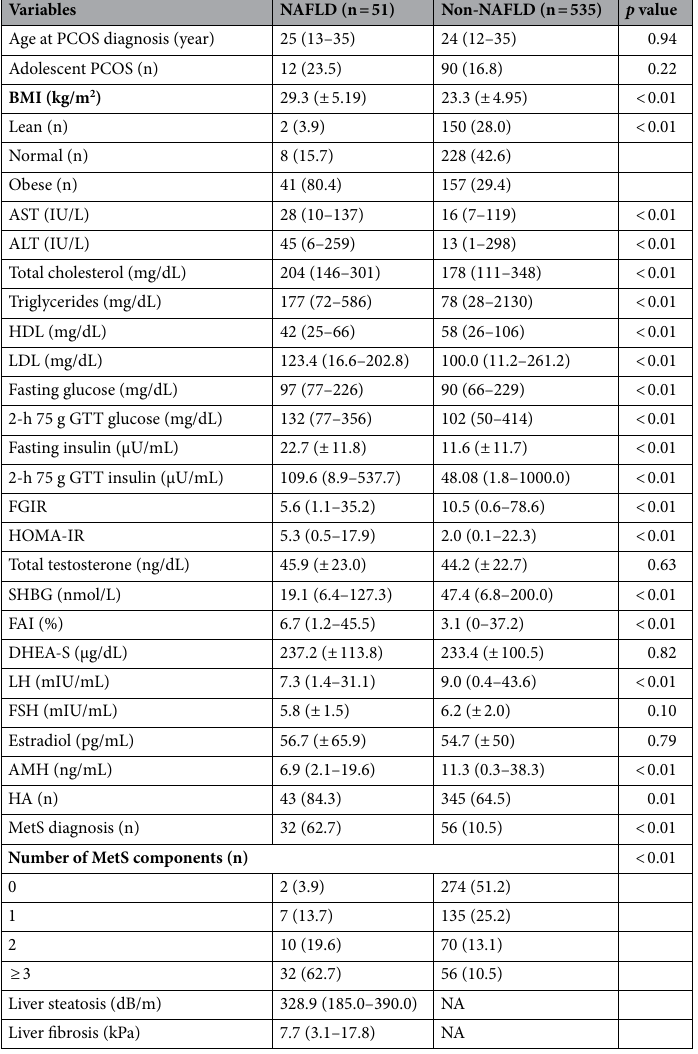
aminotransferase, AMH anti-Müllerian hormone, AST aspartate transaminase, BMI body mass index, DHEA-S dehydroepiandrosterone sulfate, FGIR fasting glucose insulin ratio, FSH follicle stimulating hormone, GTT glucose tolerance test, HA hyperandrogenism, HDL high-density lipoprotein, HOMA-IR homeostasis model assessment of insulin resistance, LDL low-density lipoprotein, LH luteinizing hormone, MetS metabolic syndrome, PCOS polycystic ovary syndrome, SHBG sex hormone binding